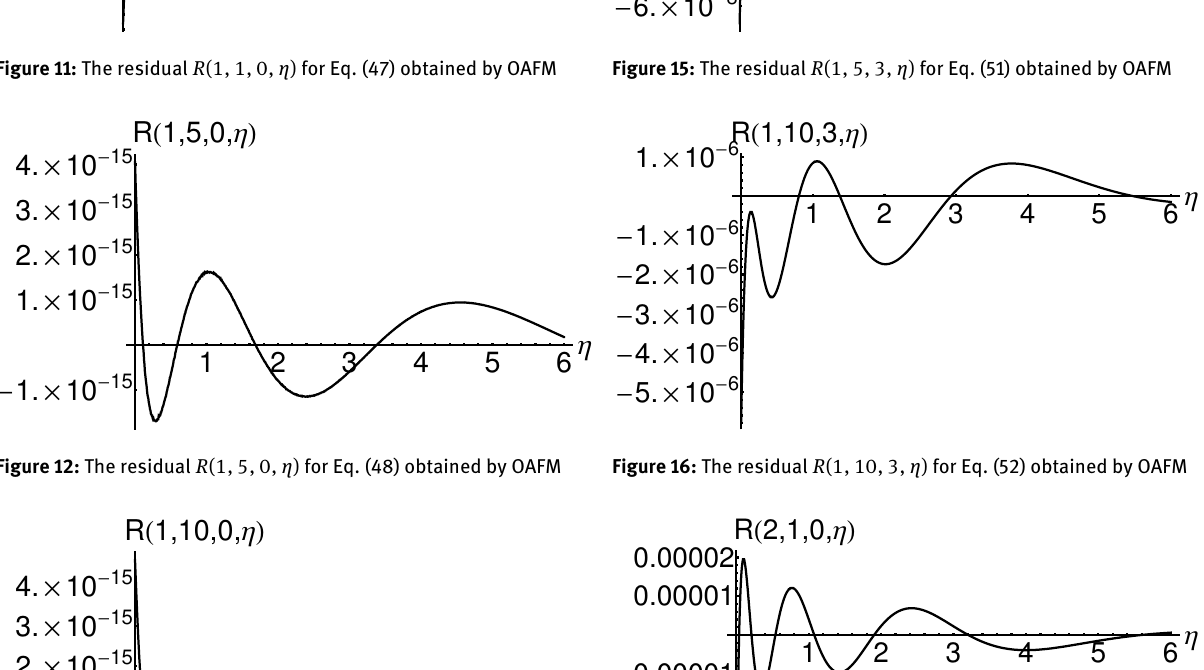
Figure 15: The residual R (1, 5, 3, η ) for Eq. (51) obtained by OAFM